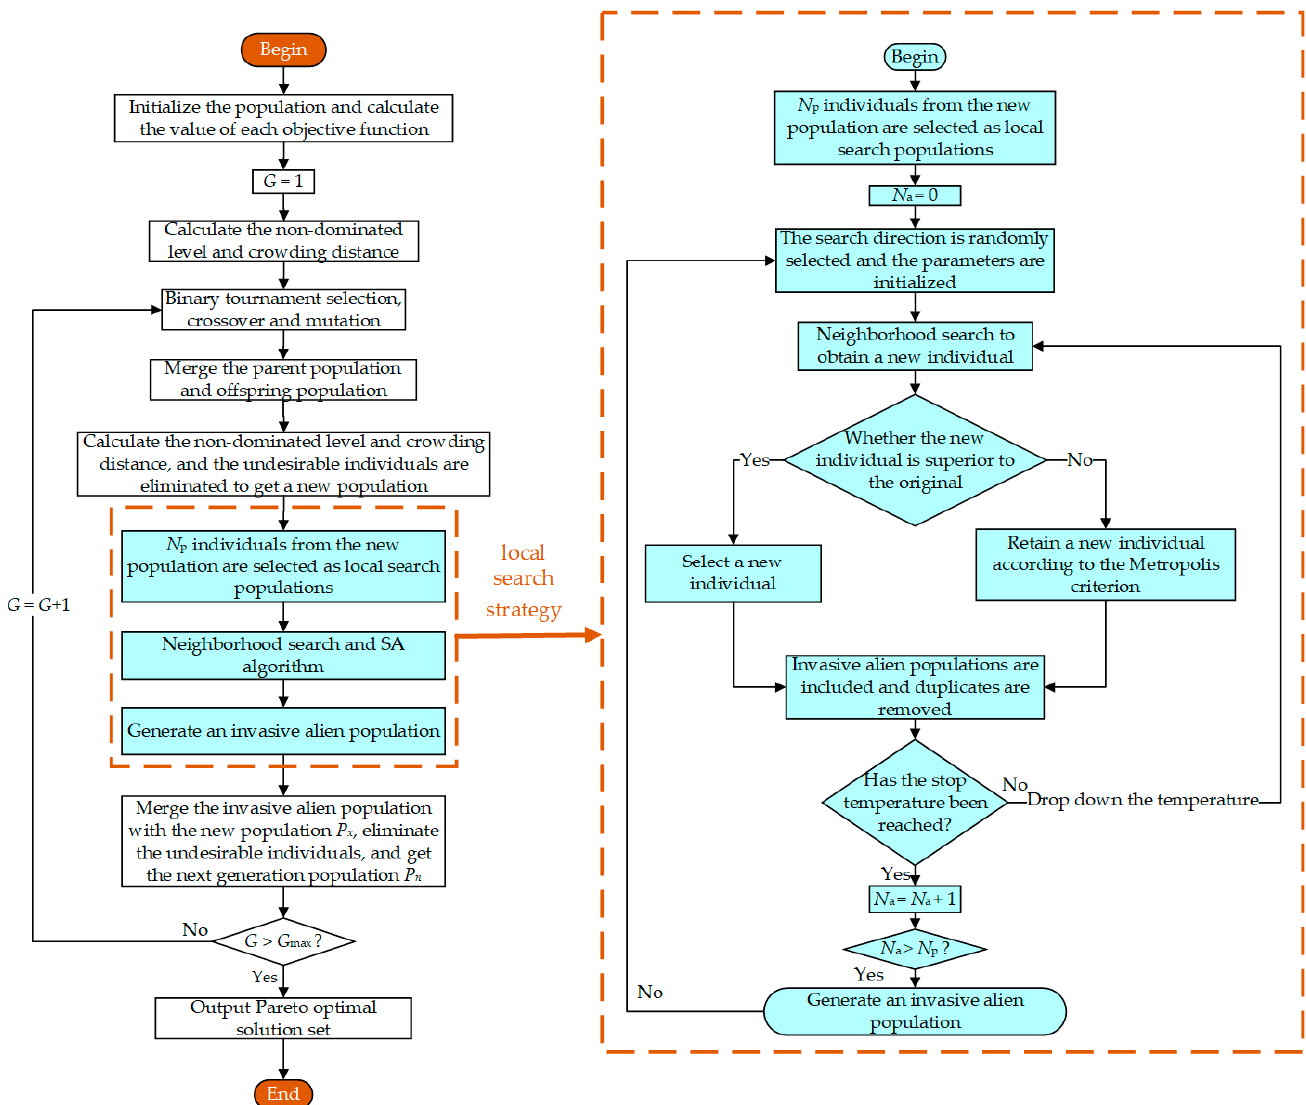
Figure 3. Process of the NSGA-II-SA algorithm.